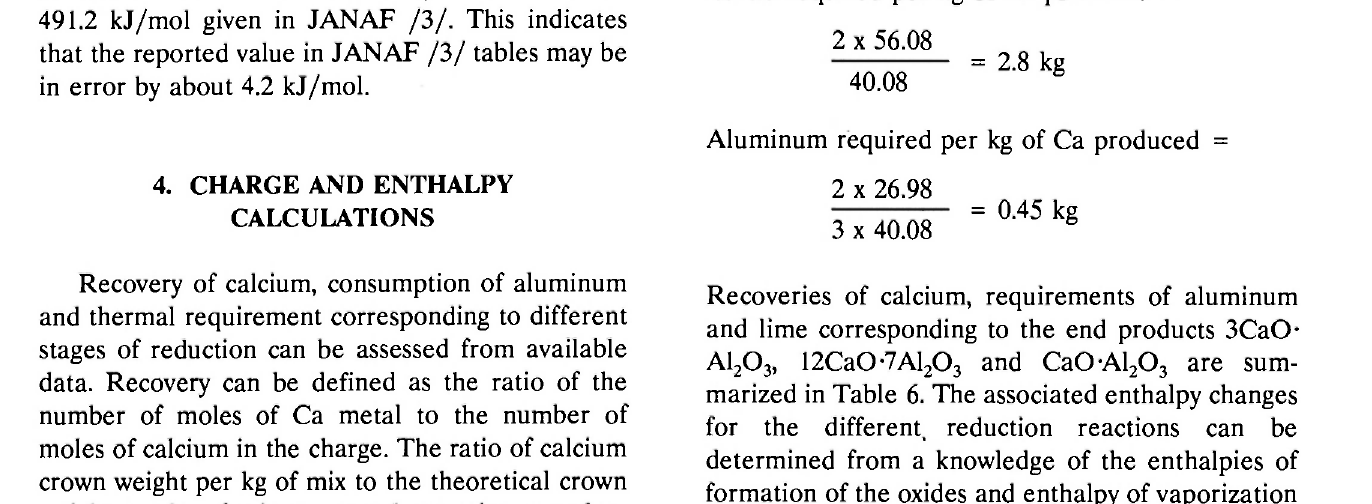
Calculated Equilibrium Vapor Pressures of Calcium for the Various Three-Phase Equilibria in the System Al-Ca-O at 1373 Κ